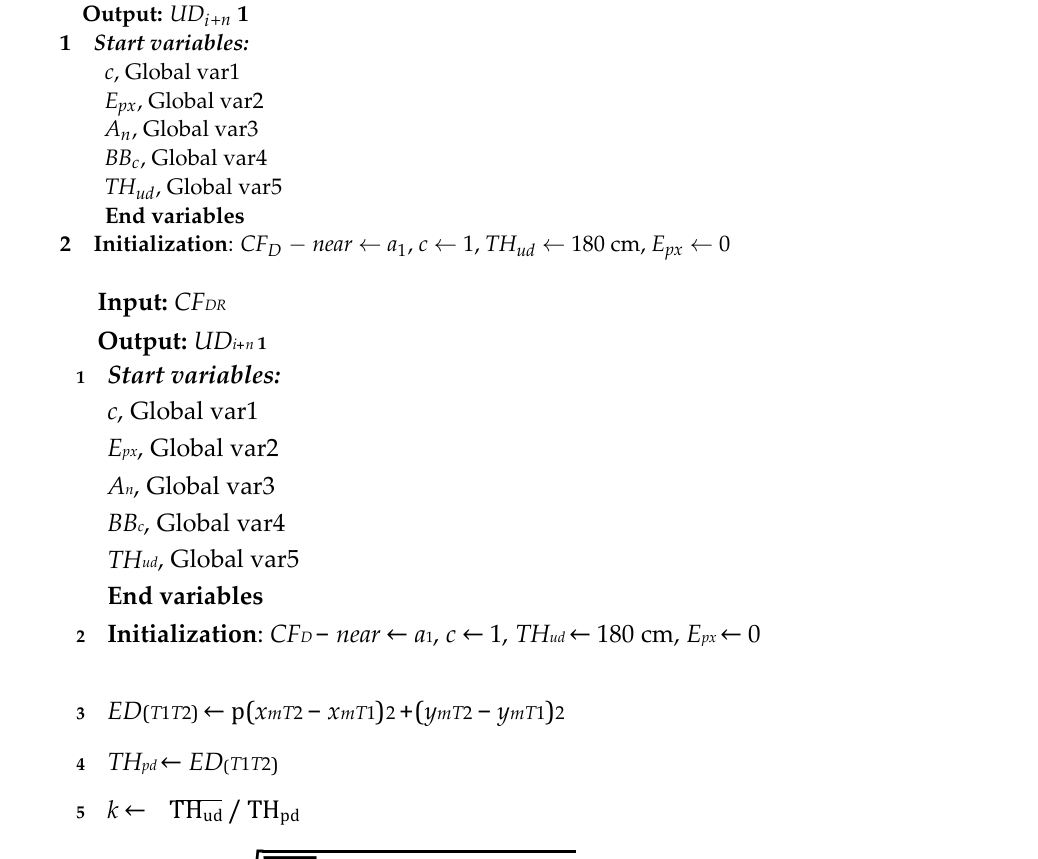
Algorithm 1: Monitoring people at CF D −